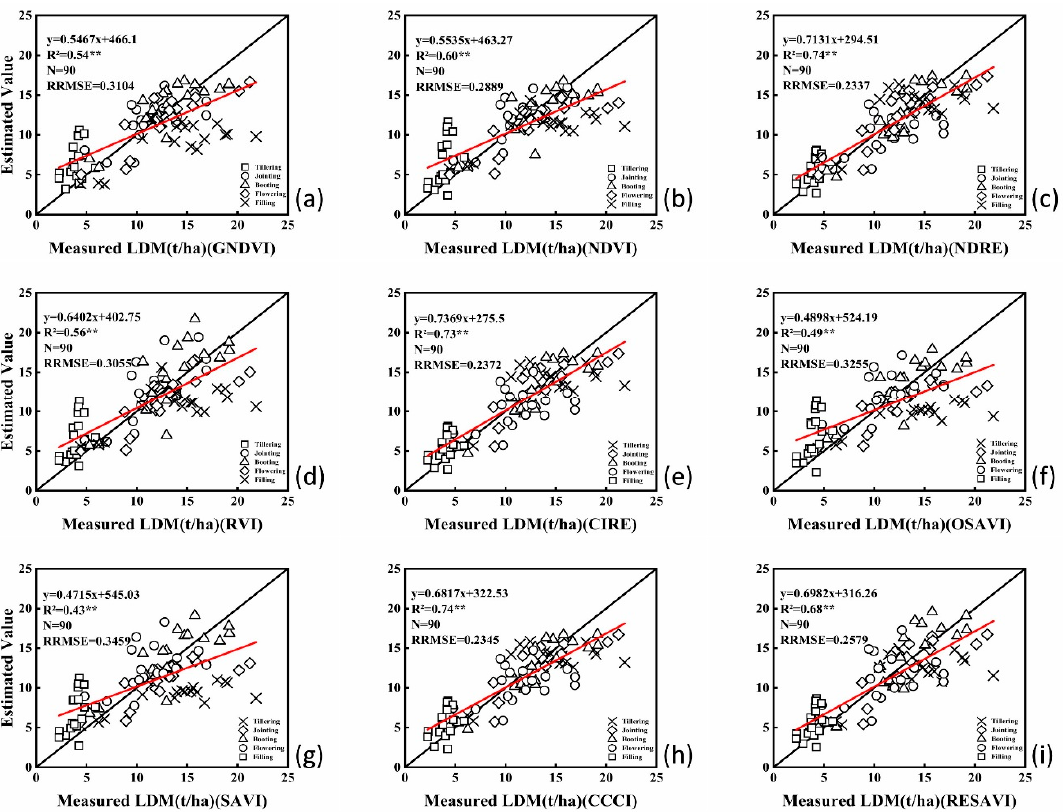
Figure 7. Validation of leaf dry matter (LDM) estimation models for the entire growth season of wheat: ( a ) GNDVI; ( b ) NDVI; ( c ) NDRE; ( d ) RVI; ( e ) CIRE; ( f ) OSAVI; ( g ) SAVI; ( h ) CCCI; ( i ) RESAVI.